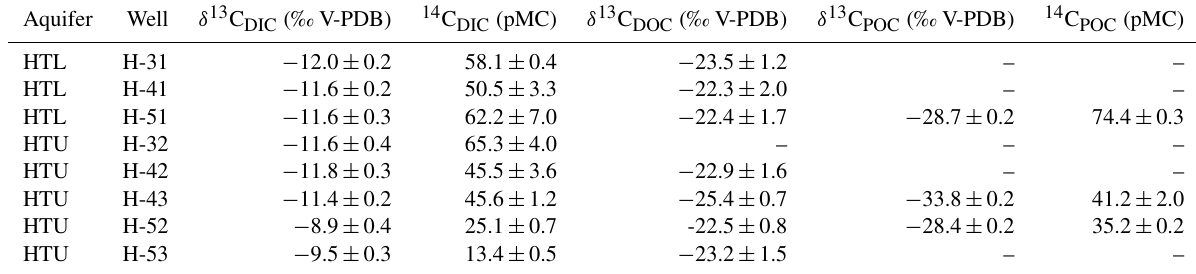
Table 2. Measured isotopic data of DIC, DOC, and POC. Aquifer